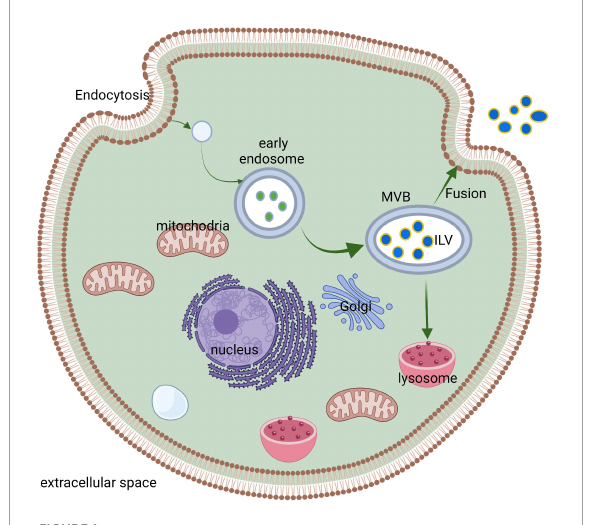
FIGURE1 A common process for EVs synthesis and release. Cells internalized the cellular components/extracellular ligands and then formed the early endosome. Subsequently, the early endosome matured into MVB, and the inward budding of early endosomes formed ILVs. In the last step, MVB either digests and degrades after fusion with lysosomes or releases exosomes through fusion with cell